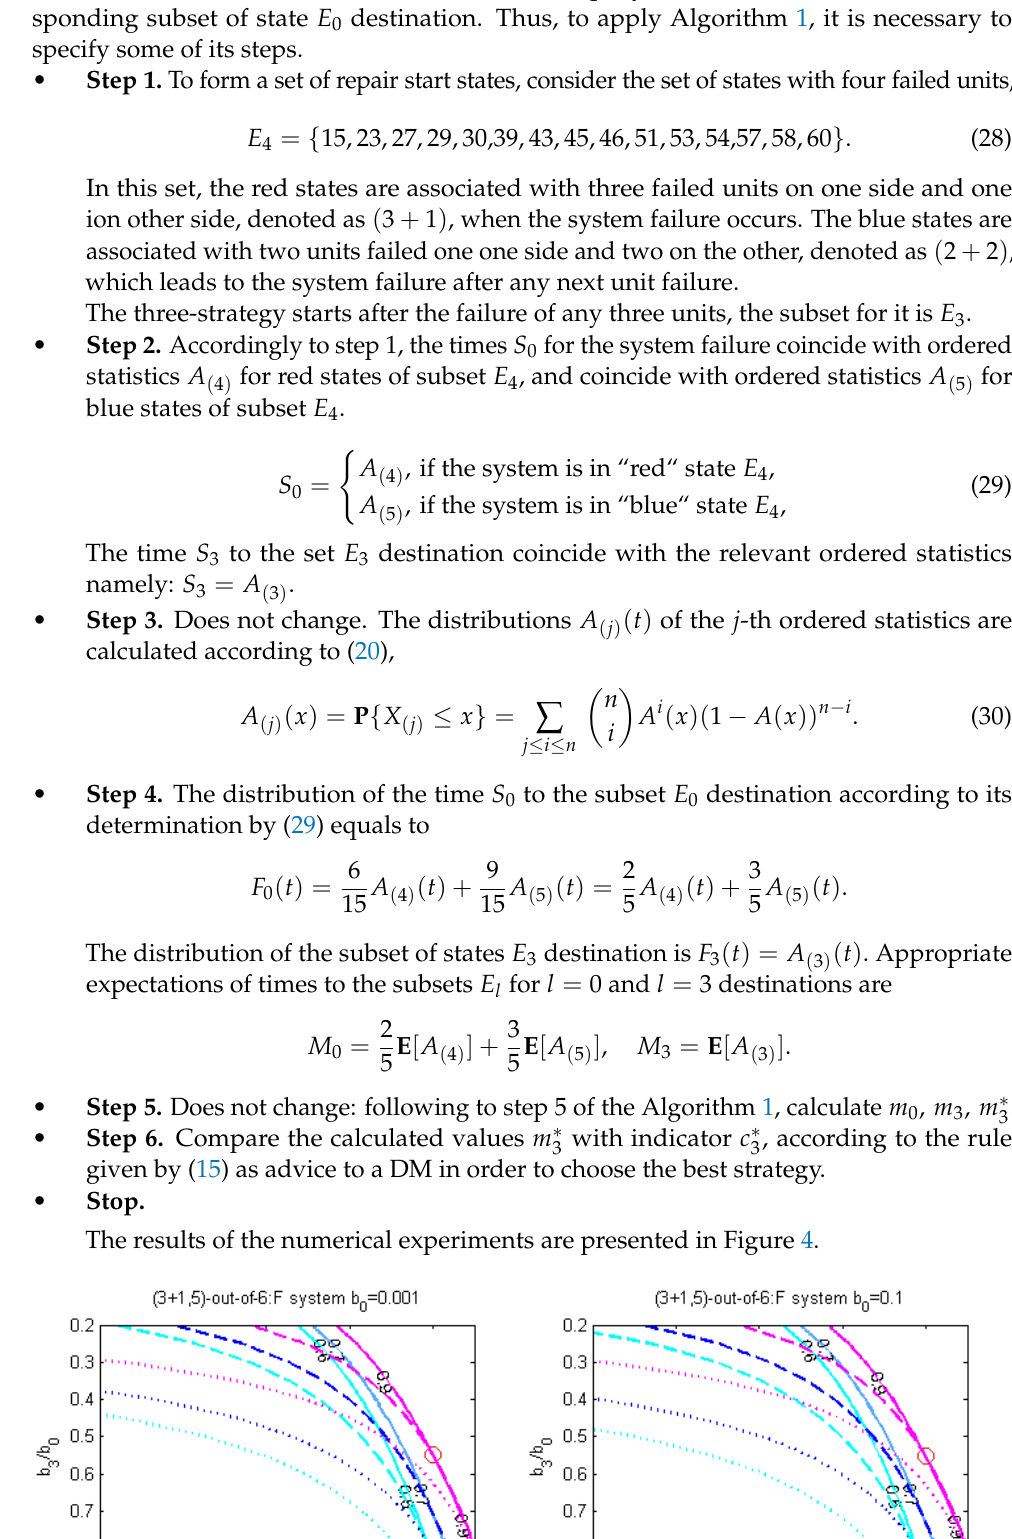
versus variation coefficient v and fraction b 3 3